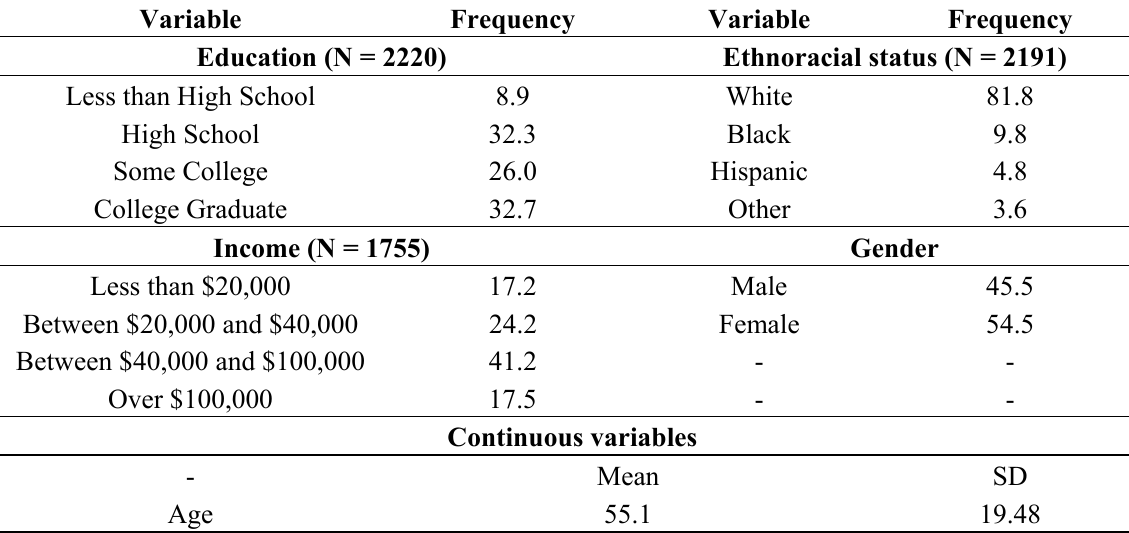
Table 2. Univariate statistics for independent